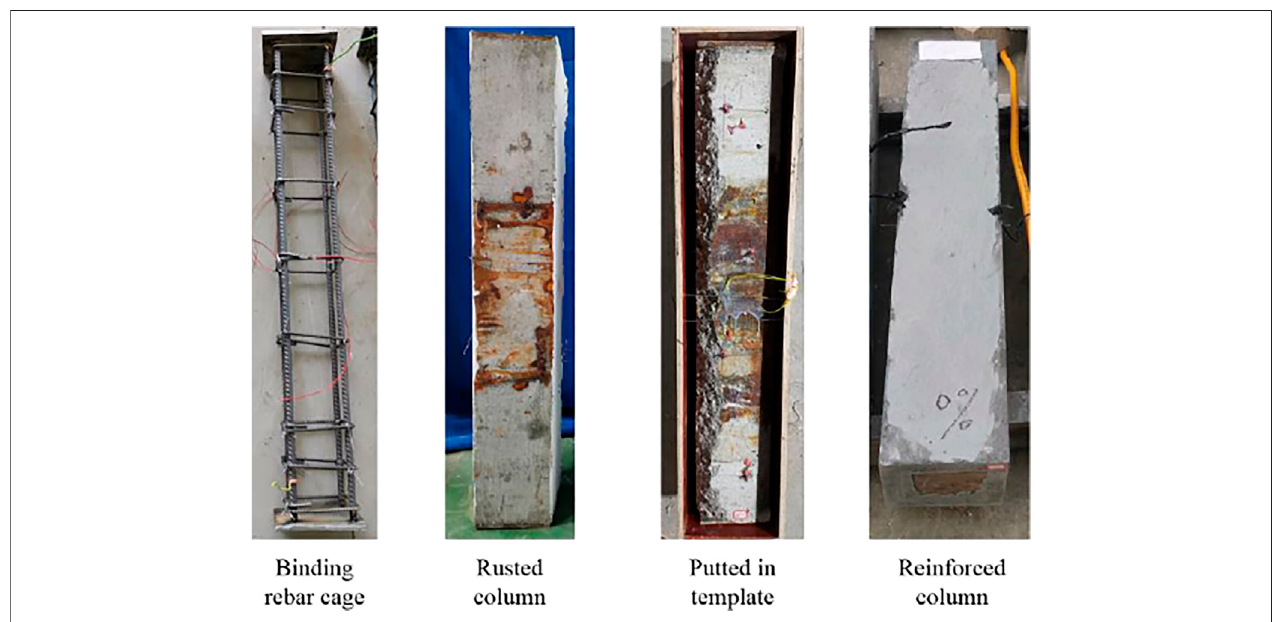
FIGURE 2 | Main process of specimen fabrication.